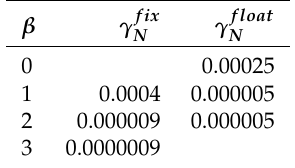
Table 2. Values for γ fix